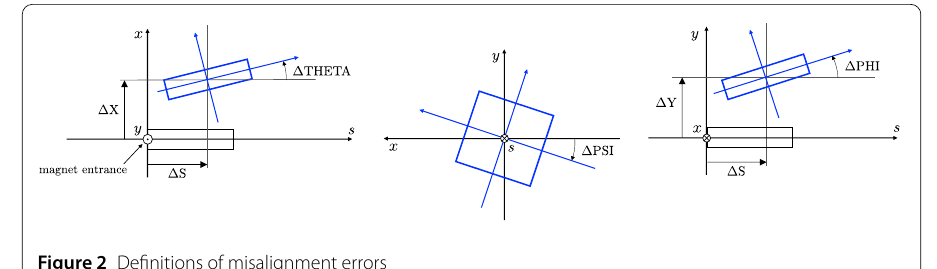
Figure 2 Definitions of misalignment